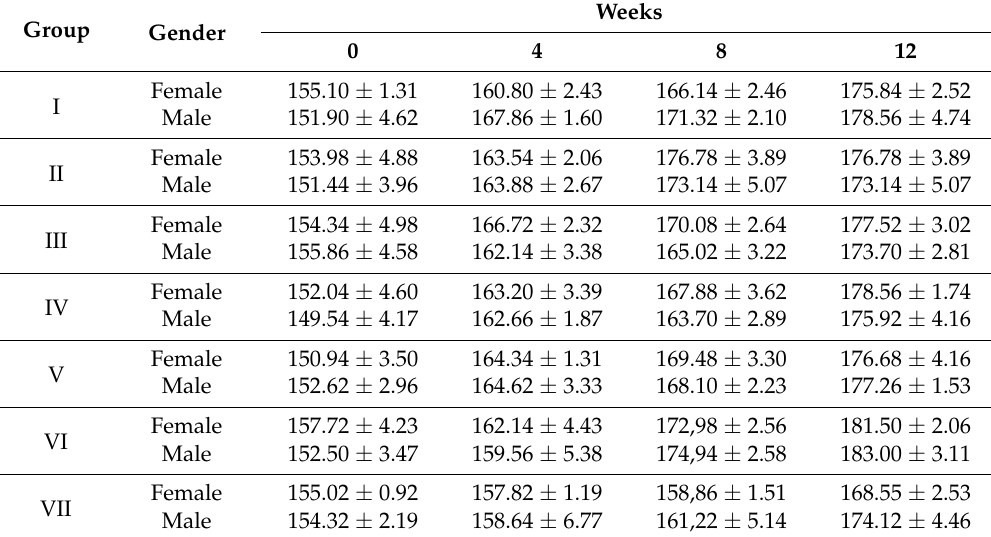
Table 1. Effect of P. fel-terrae leaf extract on body weight (Mean ±